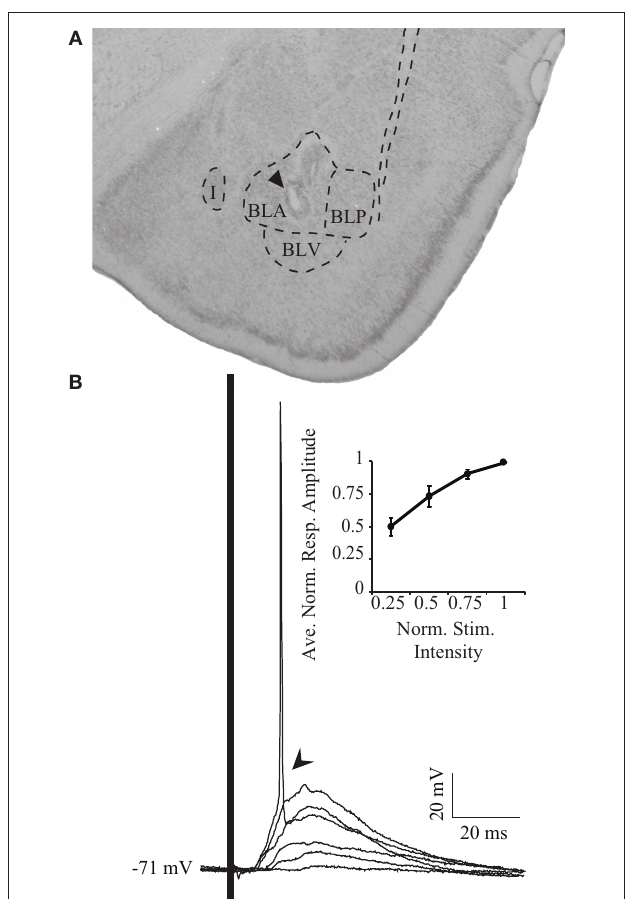
FIgure 2 | electrical stimulation of BLA. (A) Representative histological verification of stimulating electrode positioning in BLA. The arrowhead points to the site of the electrolytic lesion. I: intercalated nucleus of the amygdala; BLA, basolateral amygdala, anterior; BLP, basolateral amygdala, posterior; BLV, basolateral amygdala, ventral. (B) Synaptic responses to increasing intensities of stimulation. Note that the highest stimulation intensity results in the firing of an action potential. The inset shows the cumulative normalized response/ intensity curve for the population of neurons recorded. Data are presented as mean ± SEM. x -axis: normalized stimulus intensity; y -axis: averaged normalized amplitude of